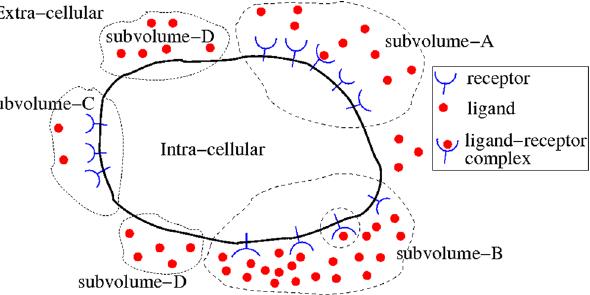
Figure 1. Schematic of receptor-ligand distributions within the cell. The uneven distribution of ligands and receptors can be considered as the sum of multiple subvolumes, where the distributions of each subvolume are approximately uniform. The structure of the subvolumes is not necessarily fixed in time and would change with its own